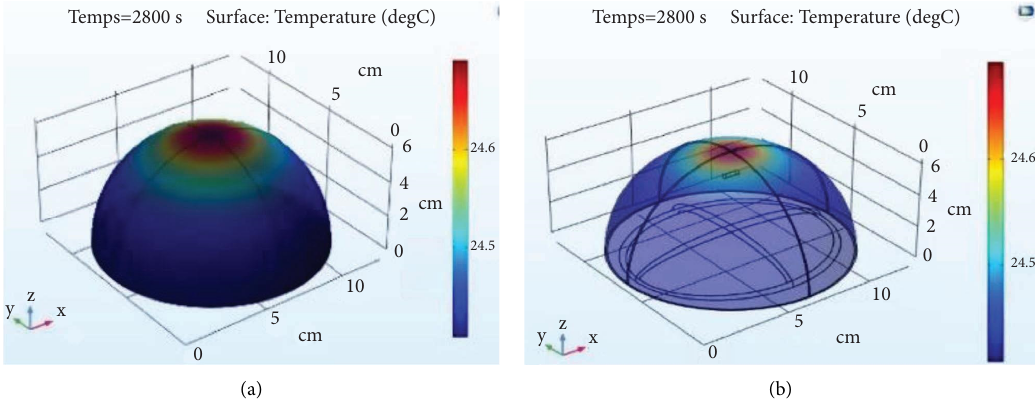
Figure 5: Termal distribution from a 15mm depth tumor (a) Simplifed phantom model and (b) Approximated phantom model. Temps=2800 s Surface: Temperature (degC)